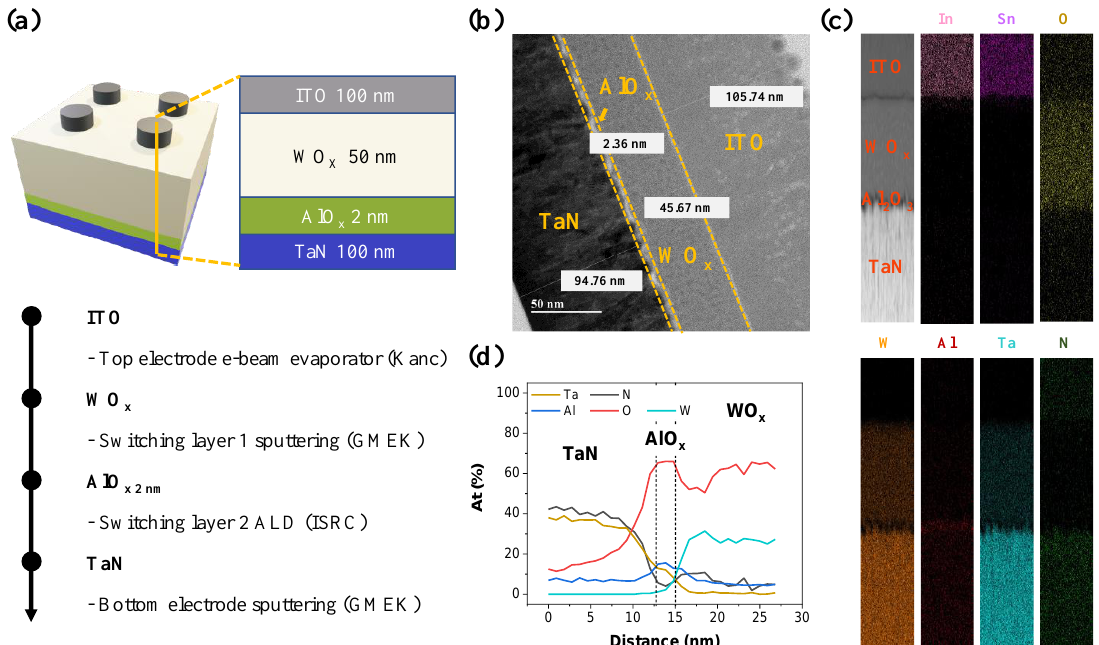
Figure 1. ( a ) The schematic showing the structure of ITO/WO x /AlO x /TaN device and the brief fabrication process; ( b ) STEM image; ( c ) EDS mapping image; and ( d ) Line scanning for the atomic ratio of the device.